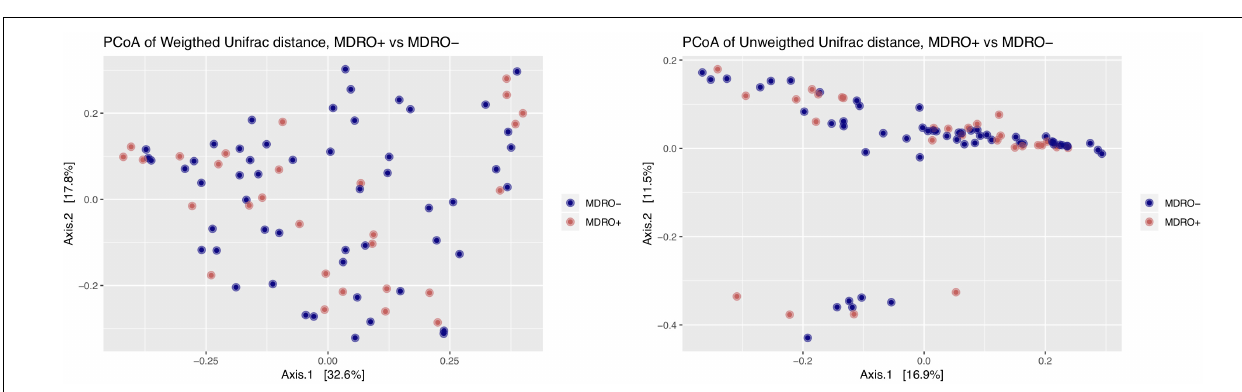
FIGURE 5 | Principal coordinates analysis (PCoA) of weighted and unweighted UniFrac distances between study subjects according to MDRO acquisition status [MDRO + (orange); MDRO- (blue)]. Differences in clustering patterns were tested using the ADOINS test ( P > 0.05). MDRO, multidrug-resistant